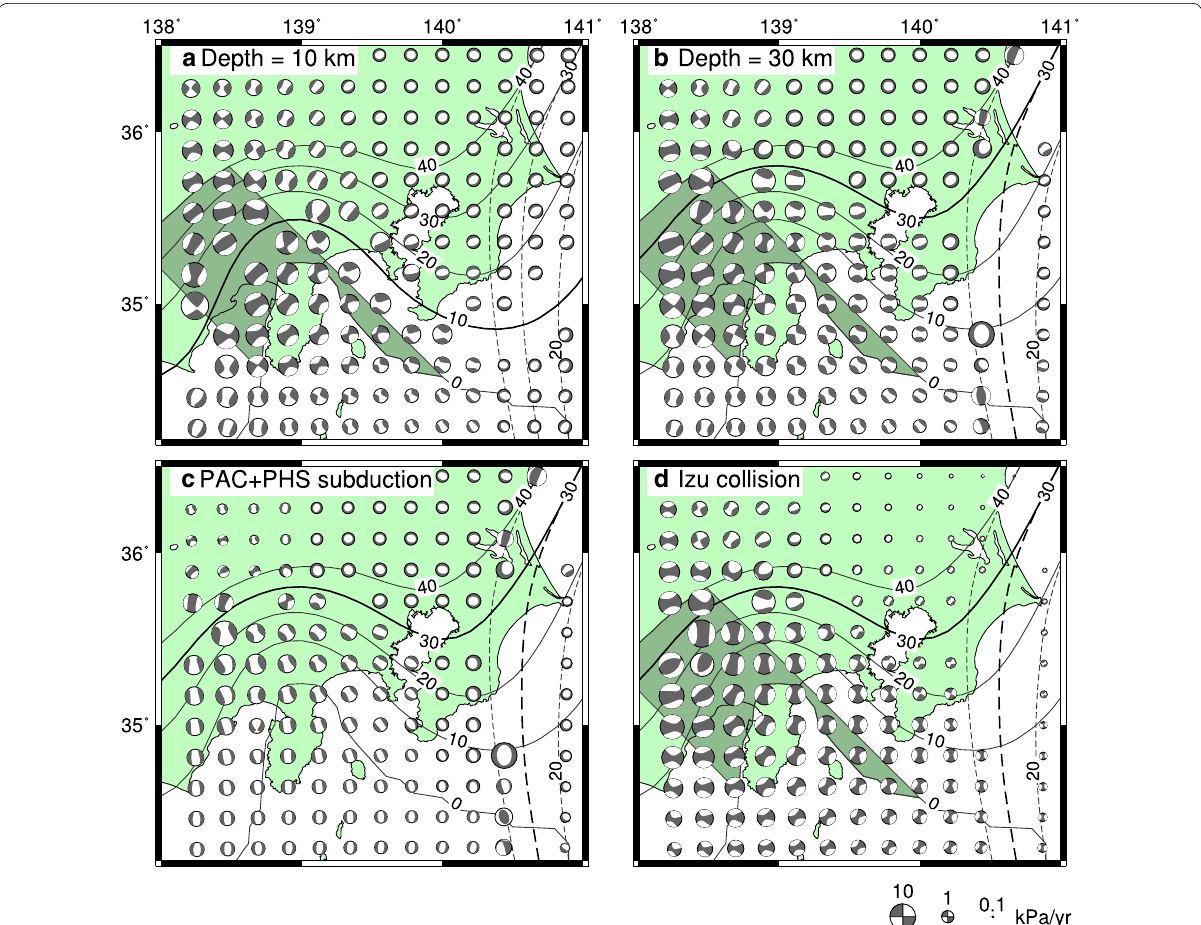
Fig. 3 Calculated stress rates around Kanto Basin at depth of a 10 km and b 30 km. Contribution to the stress rates at depth of 30 km from c PAC and PHS plate subduction and d collision of Izu Peninsula. Stress pattern is represented by a lower hemisphere projection. Shaded areas on plate interface indicate locked zone (Hashima et al. 2016). Contours show depth to top of subducting PHS (solid) and PAC (dashed)